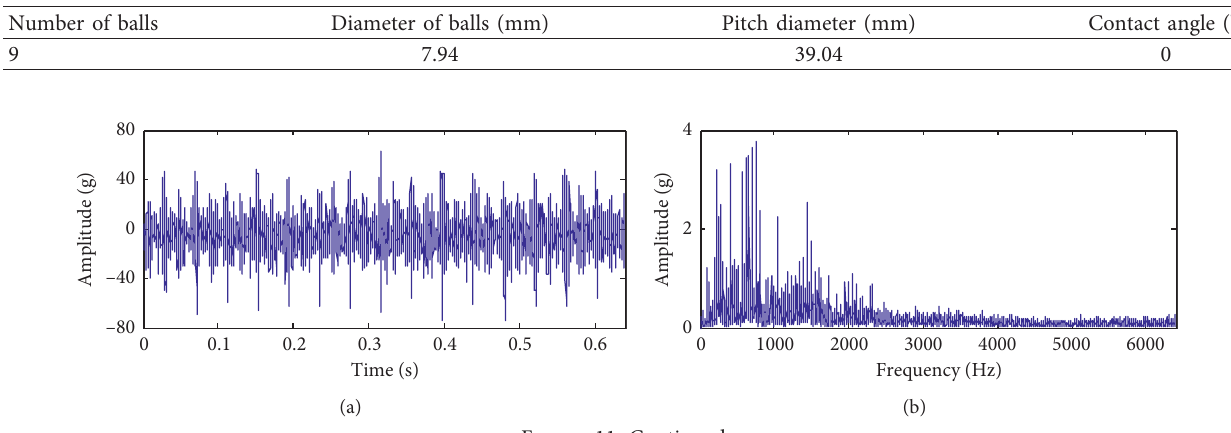
Figure 10: The experimental site: (a) the experimental platform structure; (b) the roller defect bearing; (c) the installed acceleration sensors; (d) the signal acquisition system. Table 1: Structure parameters of SKF6205 bearing.